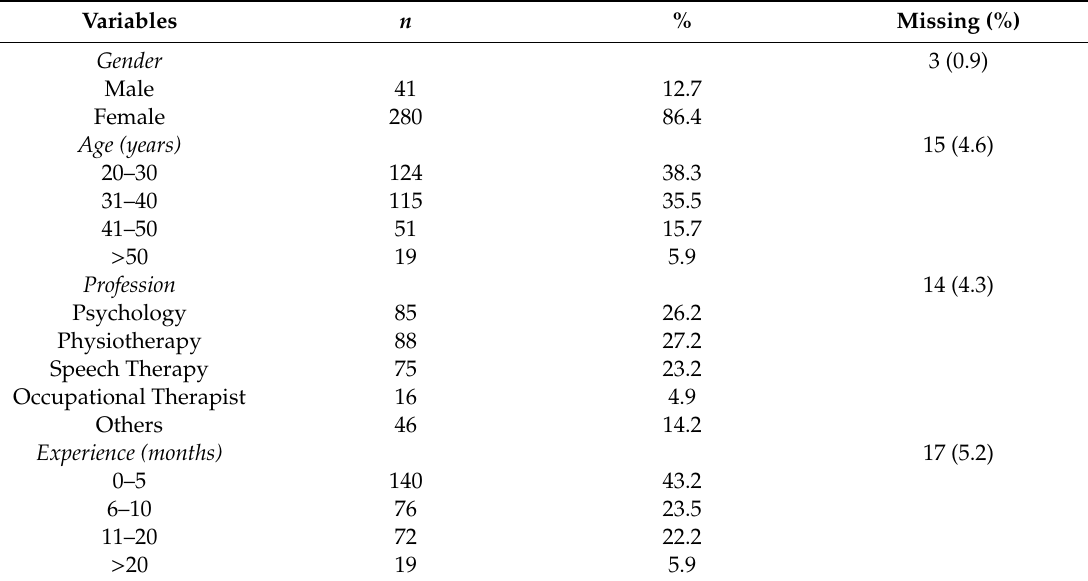
Table 1. Sociodemographic characteristics of the